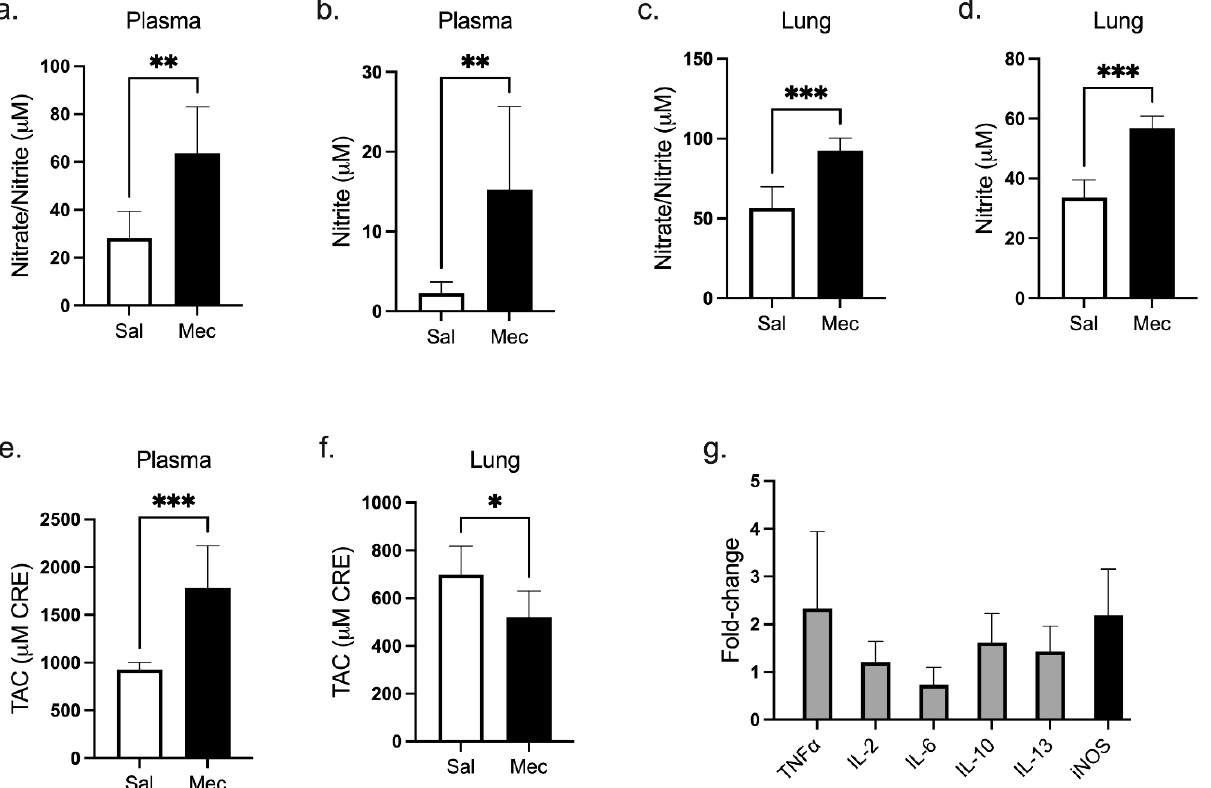
Figure 2. Changes in the NO pathway. ( a – d ) Plasma and lung tissue concentration of nitrate/nitrite ( µ M); ( e , f ) total antioxidant capacity (TAC, µ M CRE) in plasma and lung, and ( g ) cytokine and iNOS mRNA expression in lung tissue represented as a fold change. The gene expression in the saline group represents the base line (zero). Statistical comparisons for Mec vs. Sal * p < 0.05, ** p < 0.01, *** p < 0.001.